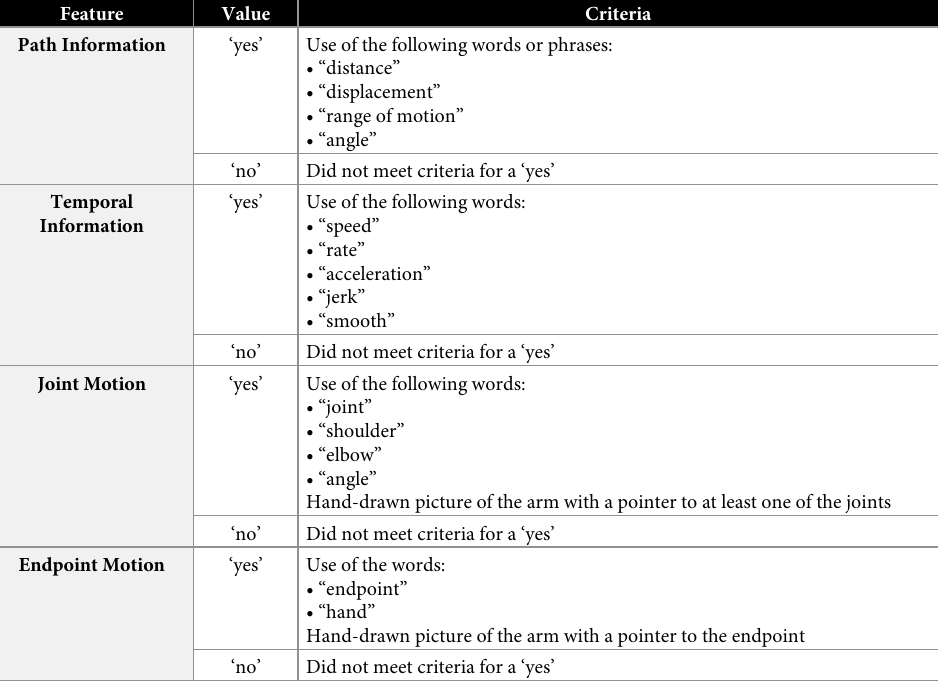
Table 1. Criteria used to encode the type of information subjects reported using to estimate stiffness in Experi- ments 1 and